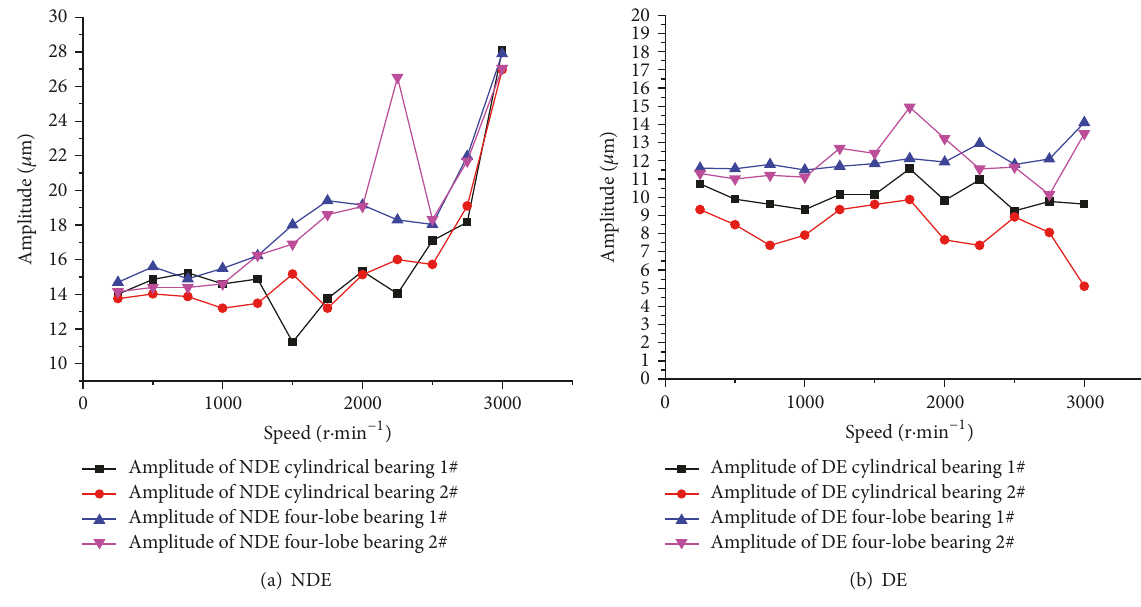
Figure 10: Comparison of the vibration of rotor supported by four-lobe bearing and cylindrical